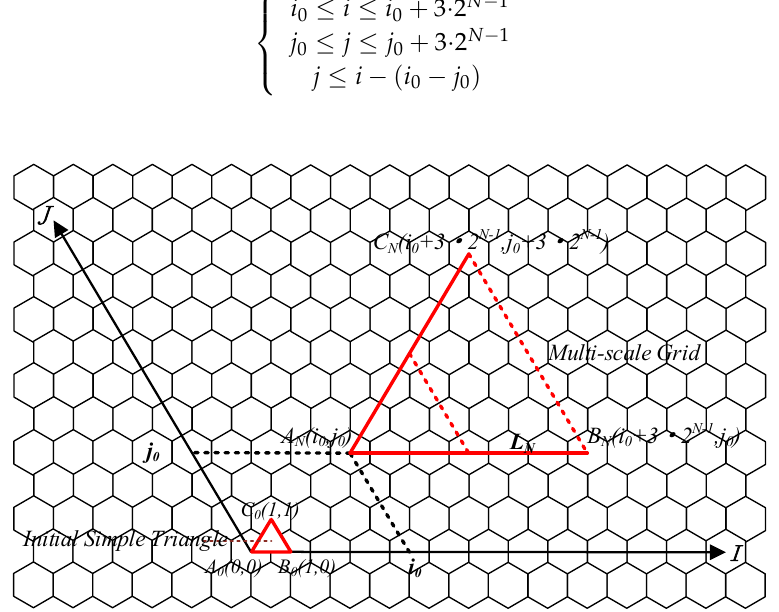
Figure 7. Multiscale Grid Boundary in the Nth Layer in the Extended Grid Skew Coordinate System.